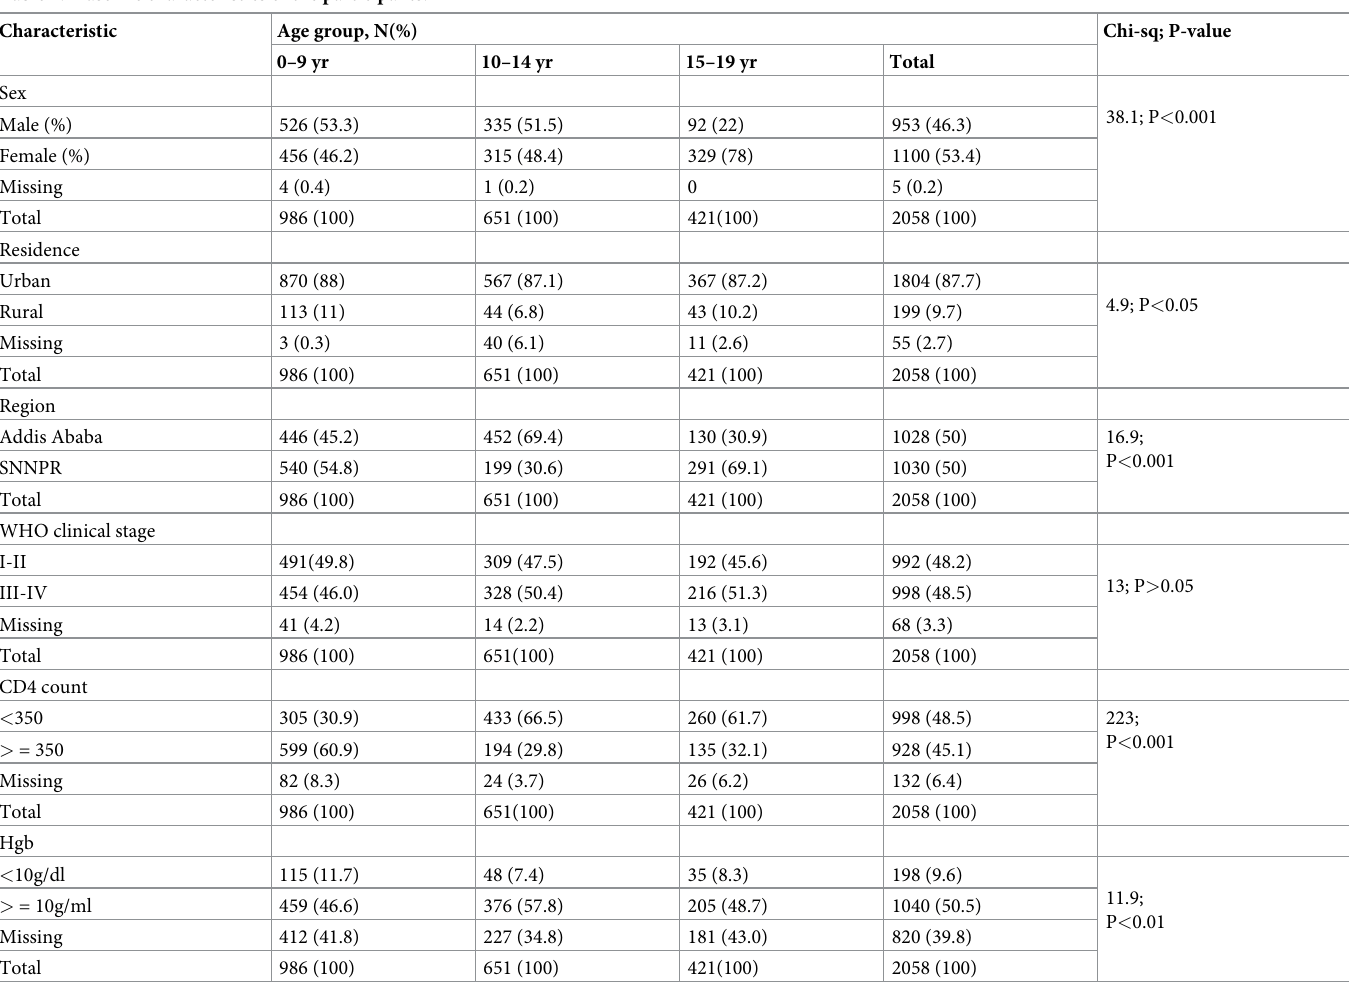
Table 1. Baseline characteristics of the